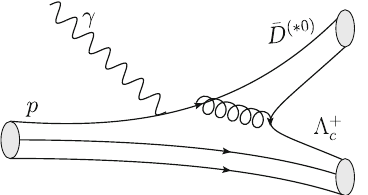
Fig. 2 Mechanism for the near-threshold J /ψ photoproduction through Λ c ¯ D ( ∗ ) which then rescatter into J /ψ p